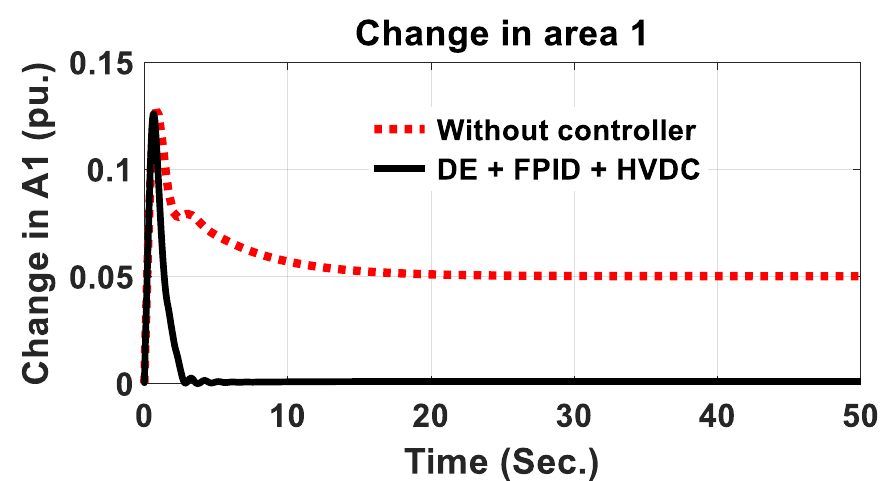
Figure 7. Comparison of controller and without controller for frequency deviation f3.